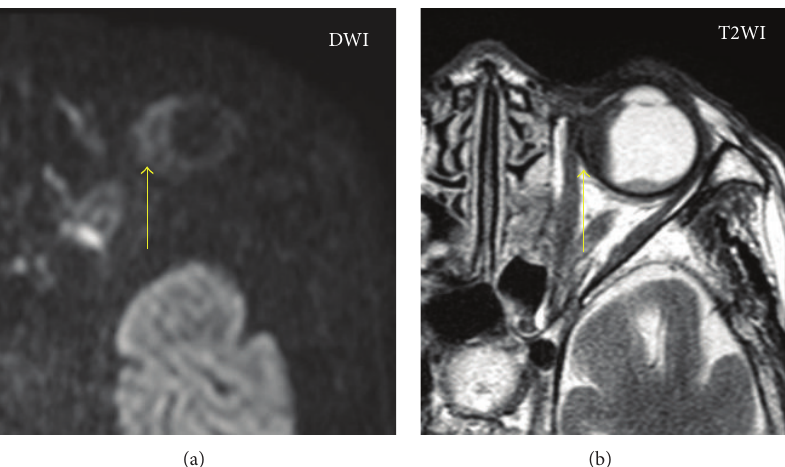
Figure 1: MRI images of the choroidal mass. Diffuse-weighted images (DWI) showed high signal intensity in left interior orbital lesion. T2-weighted image (T2WI) showed the choroidal tumor with low intensity of left eye.